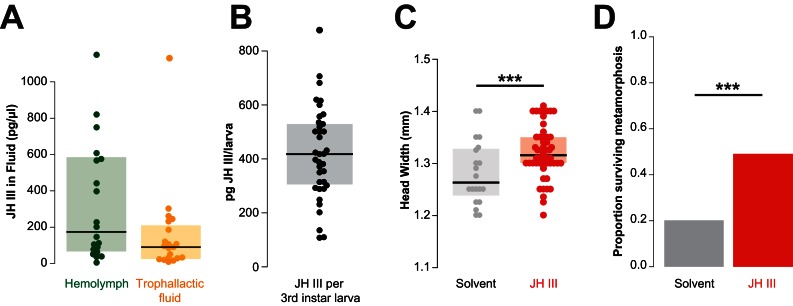
Juvenile hormone passed in trophallactic fluid increases larval growth and rate of pupation in C. floridanus.(A) JH titer in trophallactic fluid and hemolymph (n = 20; each replicate is a group of 30 workers). Source data in Figure 4—source data 1. (B) JH content of third instar larvae. Source data in Figure 4—source data 2. (C) Head width of pupae raised by workers who were fed food supplemented with JH III or solvent. General linear mixed model (GLMM) testing effect of JH on head width with colony, replicate and experiment as random factors, ***p < 9.01e−06. Source data in Figure 4—source data 3. (D) Proportion of larvae that have undergone metamorphosis when workers were fed food supplemented with JH III or solvent only. Binomial GLMM testing effect of JH on survival past metamorphosis with colony and experiment as random factors, ***p < 7.39e−06. Median values and interquartile ranges are shown in panels (A–C). Panels (C) and (D) are data from three separate experiments where effects in each were individually significant to p<0.05. Source data in Figure 4—source data 4.10.7554/eLife.20375.013Figure 4—source data 1.Hemolymph and trophallactic fluid Juvenile hormone titers for 20 pooled samples of each fluid.10.7554/eLife.20375.014Figure 4—source data 2.Juvenile hormone titers for 37 individual third instar larvae.10.7554/eLife.20375.015Figure 4—source data 3.Head-width measurements for panel 4C.10.7554/eLife.20375.016Figure 4—source data 4.Metamorphosis or death counts for panel 4D.